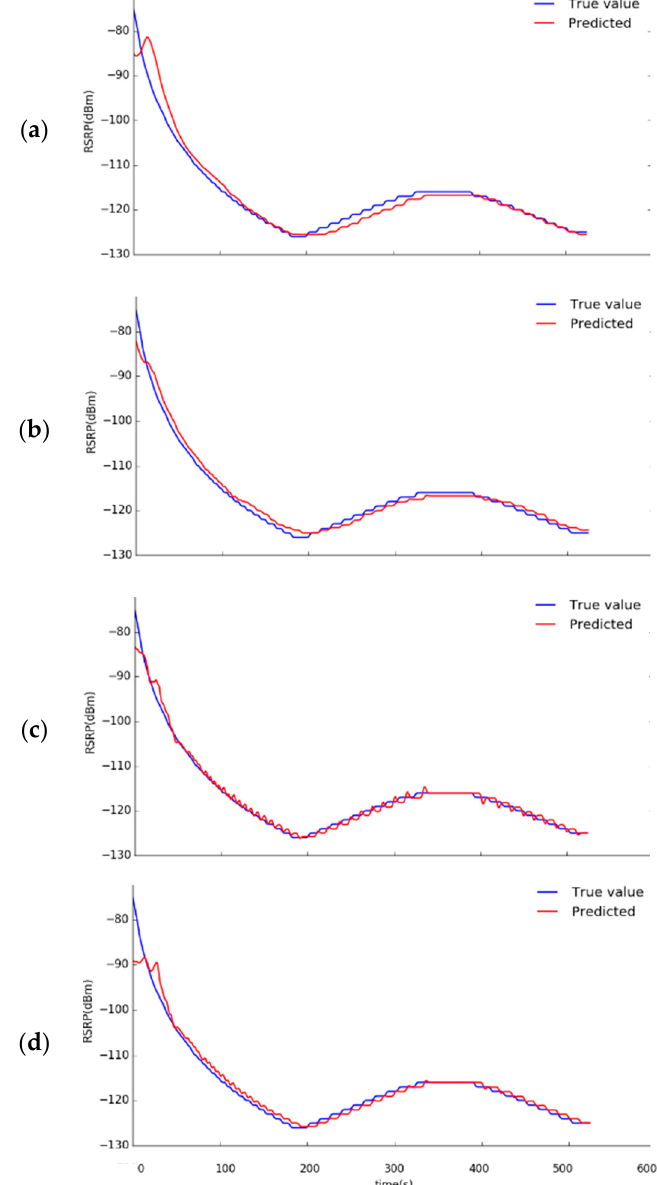
Figure 18. Predicted RSRP results for the next 8 s: ( a ) MLP, ( b ) CNN, ( c ) RNN, ( d ) LSTM.